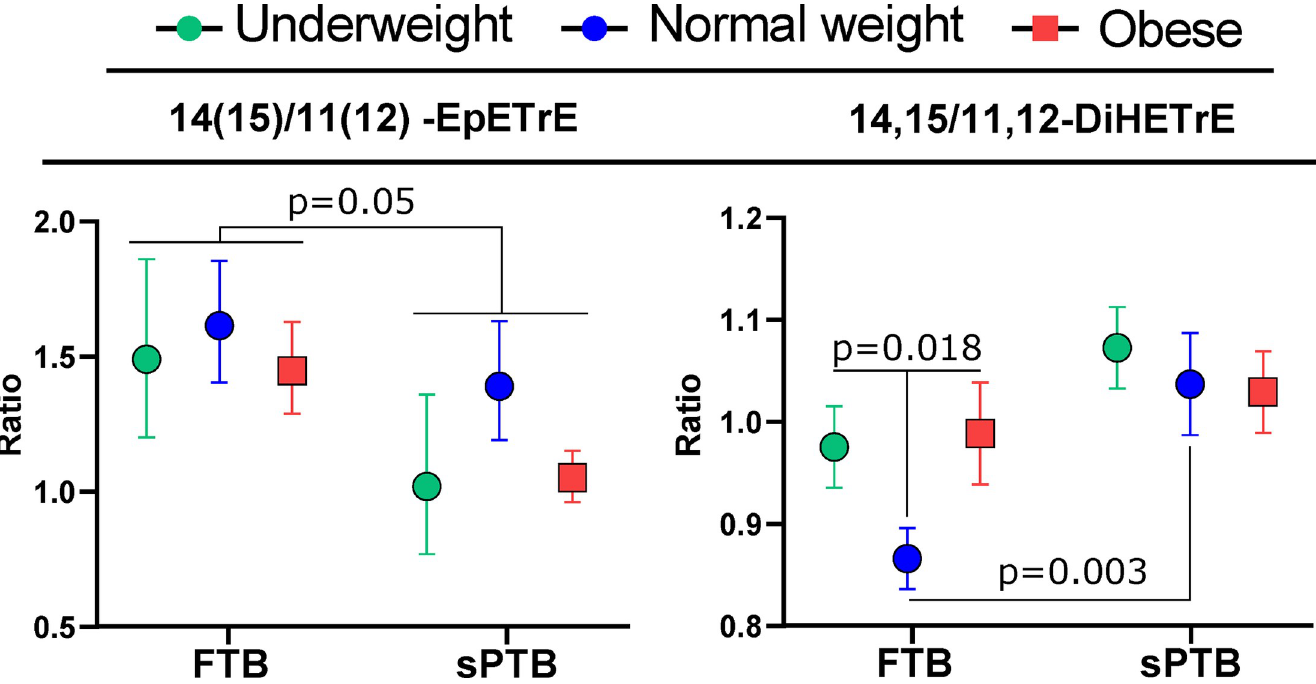
Fig 2. Regioisomer-specific differences in arachidonic acid cytochrome p450 (CYP) metabolism. Ratios of arachidonic acid CYP metabolite regioisomers (EpETrEs) and their soluble epoxide hydrolase (sEH)-dependent metabolites (DiHETrEs) stratified by BMI category and delivery group (sPTB and FTB). The regioisomeric ratios were calculated by dividing the concentrations of 14(15)-EpETrE or 14,15-DiHETrE by the concentration of 11(12)-EpETrE or 11,12-DiHETrE for epoxides and diols, respectively. The 14(15)/11(12) -EpETrE birth group effect was generated by a factorial analysis with BMI category, delivery group and the delivery x BMI interaction as fixed effects, and no significant interactions were detected. For the 14,15/11,12-DiHETrE ratio comparisons, the two p values reflect 1) the difference between FTB normal weight vs FTB obese and underweight, and 2) the difference between normal weight FTB vs normal weight sPTB. Error bars represent standard error. N = 17 per group. Point color: green–underweight; blue–normal weight; red–obese. EpETrE–epoxyeicosatrienoic acid; DiHETrE–dihydroxyeicosatrienoic acid.